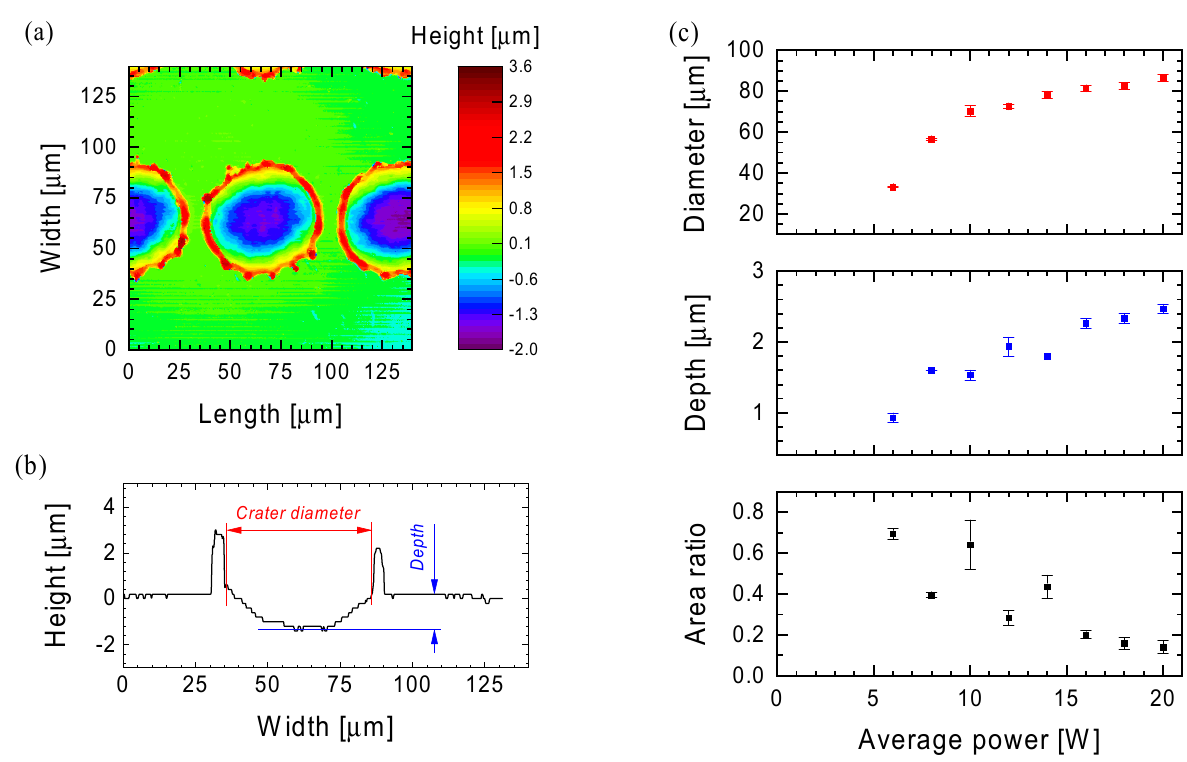
Figure 1. Surface characteristics of the Ti6Al4V alloy obtained from the confocal microscope measurements (magnification ×100), after the functionalization process carried out at the frequency of 35 kHz, the hatch distance of 100 µm and the scanning speed of 2400 mm/s. Example of a 2D crater map ( a ) and a selected crater profile ( b ) across the laser beam scanning line with the method of estimating the crater diameter and depth, after laser treatment at an average power of 8 W. ( c ) The crater diameter, depth and field ratio of the crater surface to the displaced sample material above its surface as a function of the average laser power.